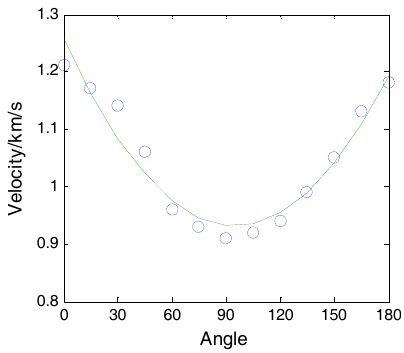
Figure 7. Wave velocities of different directions.